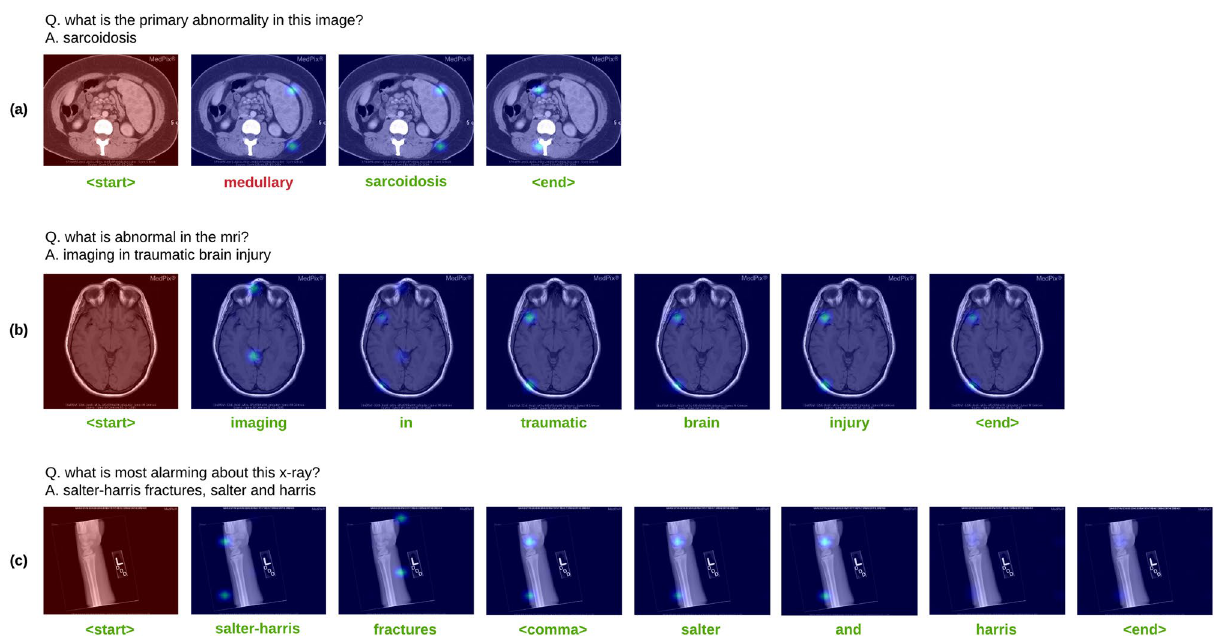
Figure 6. The attention maps produced by MedFuseNet while generating the words in the answer. There are three cases ( a ) sarcoidosis in the genitourinary system, ( b ) anoxic brain injury, and ( c ) salter-harris fracture in the